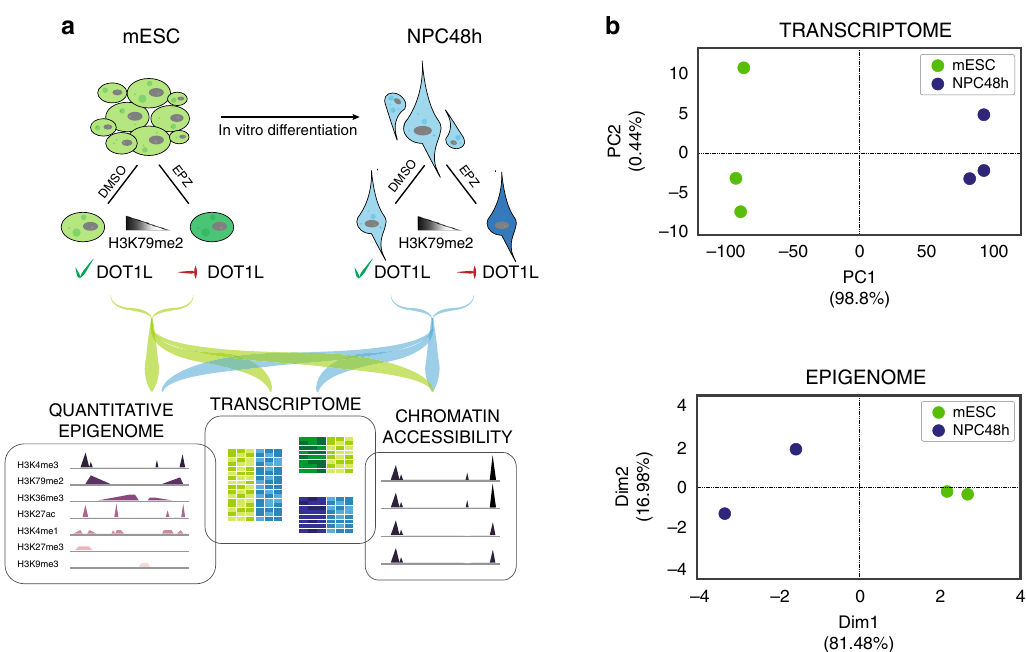
Fig. 1 Experimental design and QC of multi-omics datasets of murine in vitro neuronal differentiation. a Experimental design of this study. We differentiate mESC towards neural progenitors (NPC48h) in vitro. We treat mESC and NPC for 48 h either with the DOT1L inhibitor EPZ5676 (10 μ M) or with DMSO (1/1000) as control. For each sample, we generate transcriptomics data via RNA-seq and comprehensive epigenomes using quantitative ChIP- seq. We further map the accessible chromatin landscape for NPC48h using ATAC-seq. b Upper panel: principal component analysis of the transcriptome of mESC and NPC48h on the top 500 most variable genes (rlog transformed counts) shows a separation between the two cell types on the fi rst principal component. Lower panel: multiple factor analysis of the epigenome of mESC and NPC48h computed over the top 500 most variable 2 kb windows for each histone modi fi cation yield similar results. Biological replicates are denoted by the same